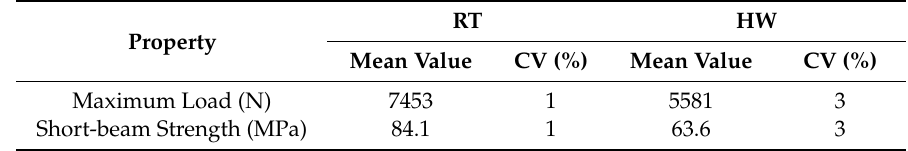
Table 9. Effect of hot-wet storage aging on the mechanical properties derived from static ILSS tests.